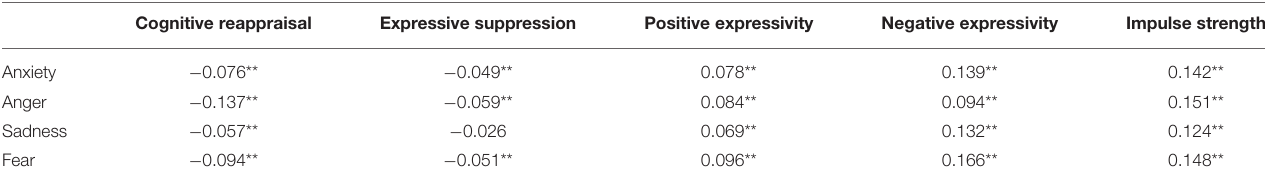
TABLE 1 | Correlation between negative emotion and emotion regulation strategy.